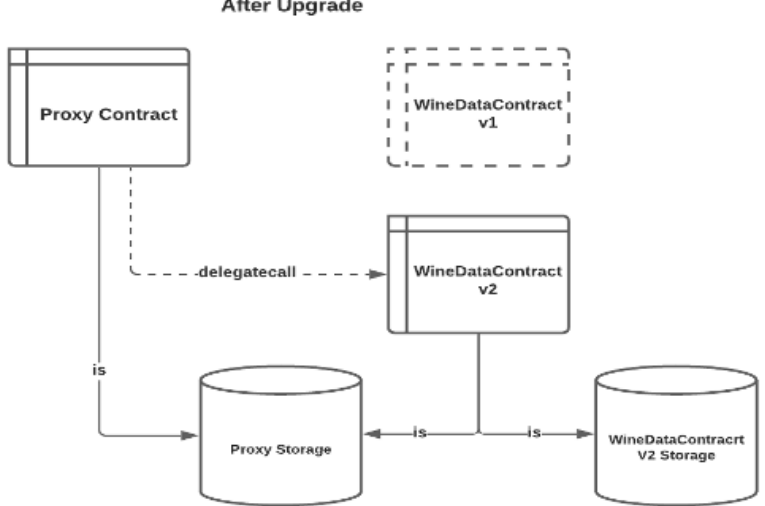
Figure 17. Proxy Pattern After Smart Contract